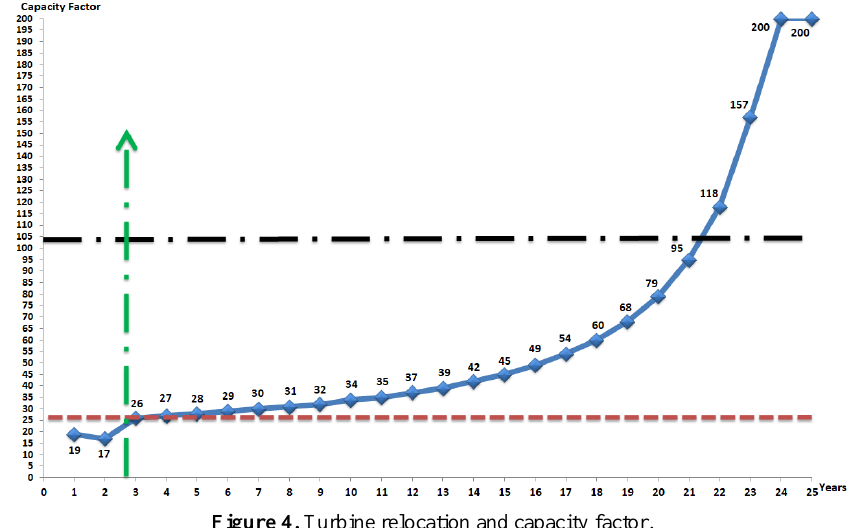
Figure 4. Turbine relocation and capacity